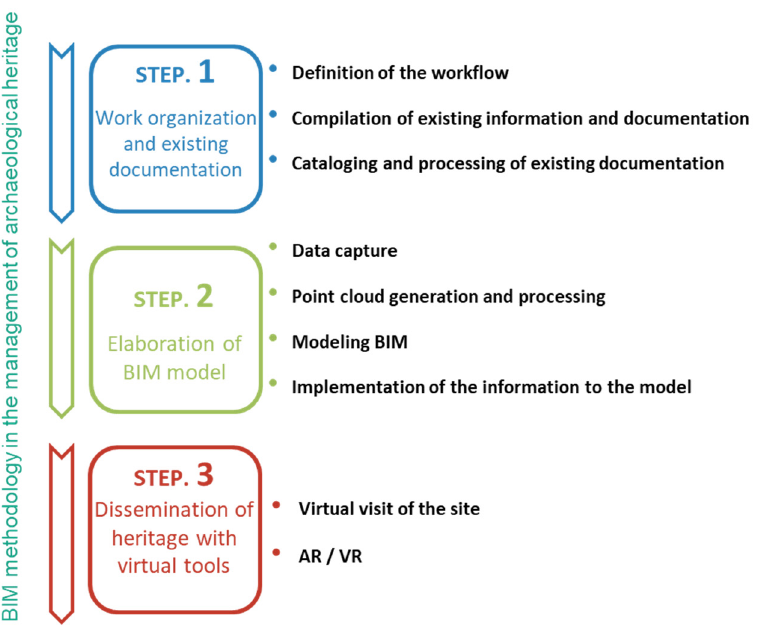
Figure 4. Outline of the methodology applied in the development of the work. The tasks carried out in each phase of the work process are defined.